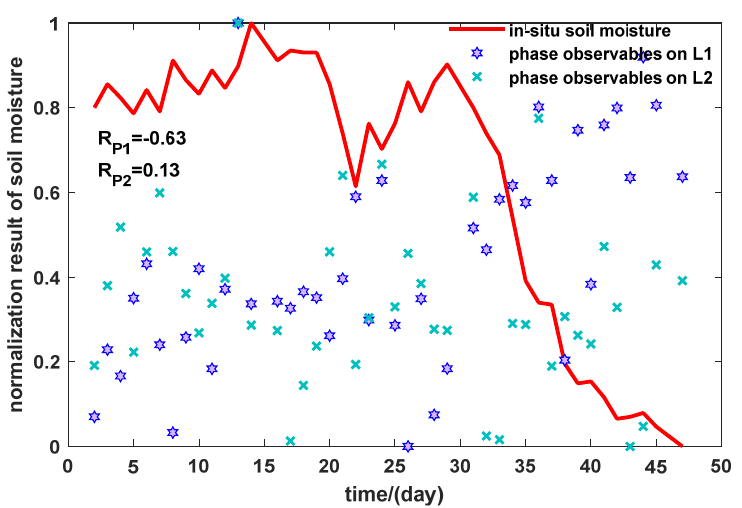
Figure 6. Normalization of in situ soil moisture and observables (phase on L1 for PRN1). We computed the correlation coefficients between the observables of amplitude and in situ soil moisture on L1 and L2 bands, as Figure 6 shows, where R P1 is the correlation coefficients of amplitude on L1, R P2 is the correlation coefficients of amplitude on L2. According to Figure 6, when the in situ soil moisture increased, the observed phase on L1 and L2 showed a trend of decrease and vice versa, and both of them have a negative correlation. The inversion results of soil moisture using GPS L1 phase observable are shown in Figure 7.